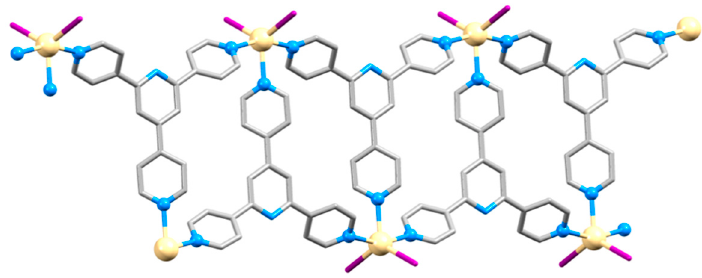
Figure 36. Part of the 1D ‐ ladder in [Cd( 38 )I 2 ] n (DSC refcode USECEC).